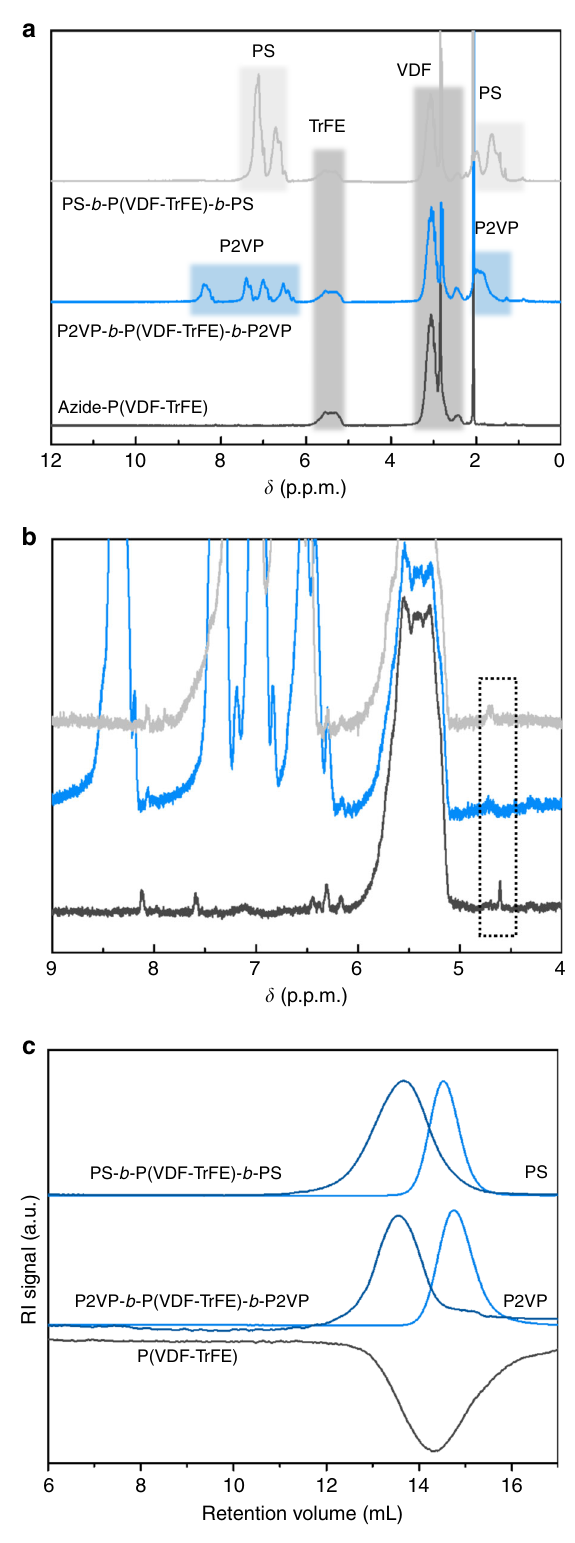
Fig. 2 Synthesis of block copolymers. a 1 H NMR spectra of telechelic P(VDF-TrFE) and corresponding block copolymers with P2VP and PS; P(VDF-TrFE), PS and P2VP peaks are highlighted with dark gray, light gray and blue, respectively. b Enlarged 1 H NMR spectra demonstrate complete shift of the methylene protons signal at 4.60 ppm and full conversion of P(VDF-TrFE) azide end groups. c GPC of P(VDF-TrFE) and its block copolymers. All elugrams are obtained in THF at a fl ow rate 1.0 mL min − 1 at 35 °C. In THF, P(VDF-TrFE) gives negative R. I. signal due to its